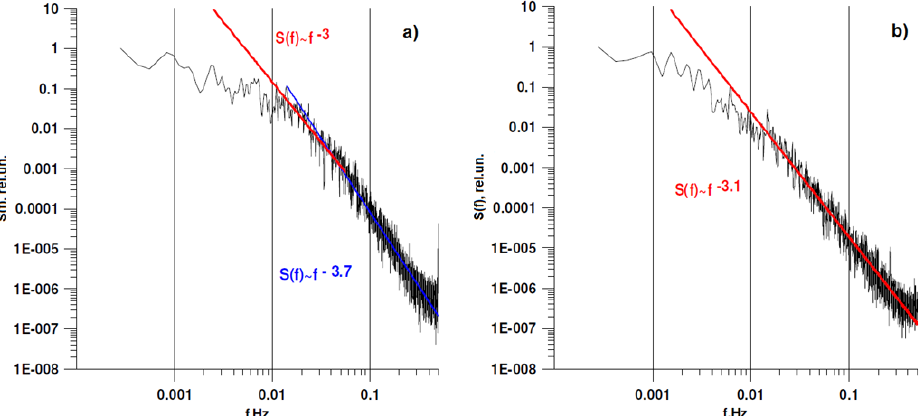
Fig. 7. Two spectra (a, b) of the same observation day (23 July) calculated for two-hour periods, each with different stability conditions: (a) 21:00–23:00UT (stable conditions, Ri ≈ 1), and (b) 06:00–08:00UT (unstable conditions, Ri ≈ –5.5).